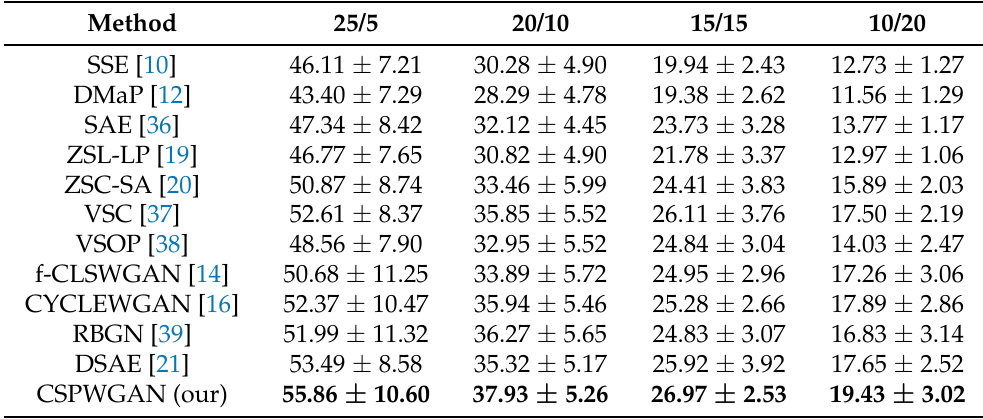
Table 3. With different seen/unseen ratios, the average ZSL classification accuracies and standard deviation (%) of our CSPWGAN model and the sota methods on the AID30 dataset. Bold font denotes the best result.